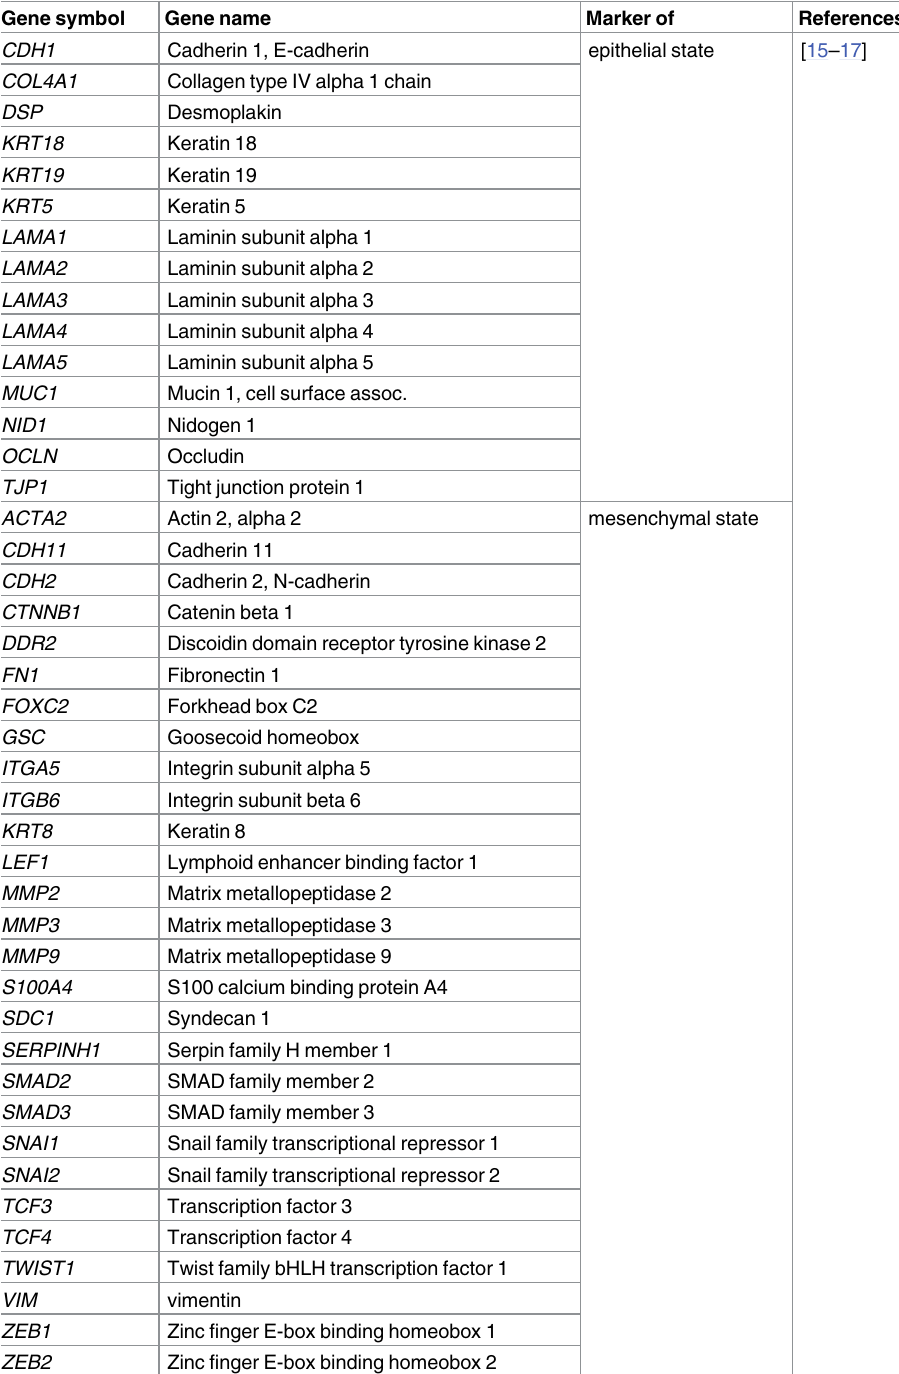
Table 2. List of genes involved in epithelial-to-mesenchymal transition (based on literature review). Gene